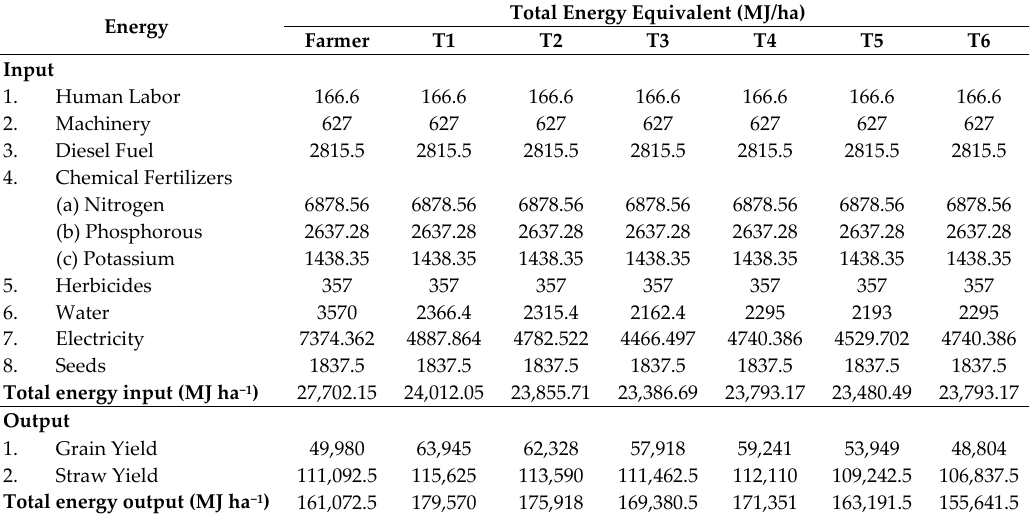
Table 3. Energy consumption and production in wheat production.